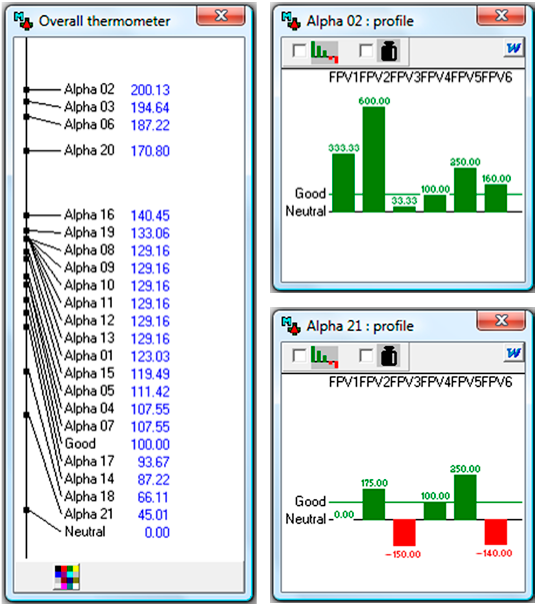
Fig. 5. Final ranking of customer loyalty and performance profiles for the best and worst